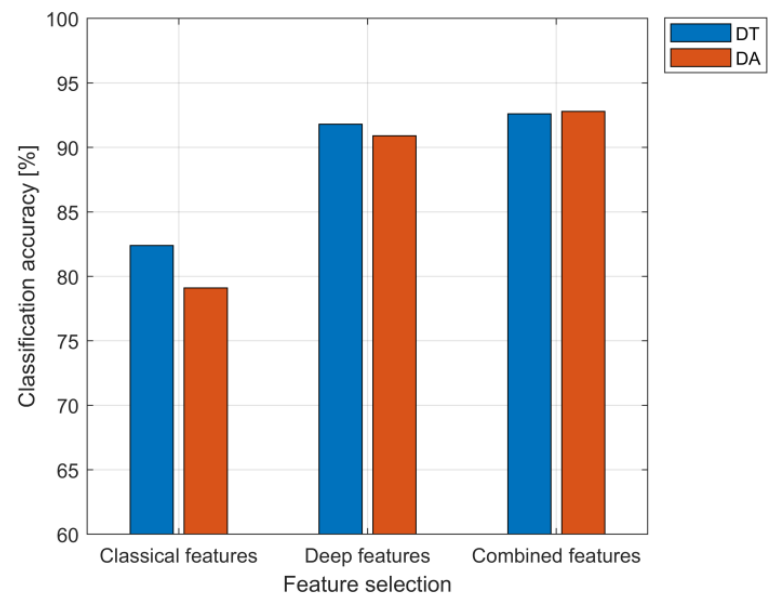
Figure 4. Classification accuracies of DT and DA classifiers for different feature sets.